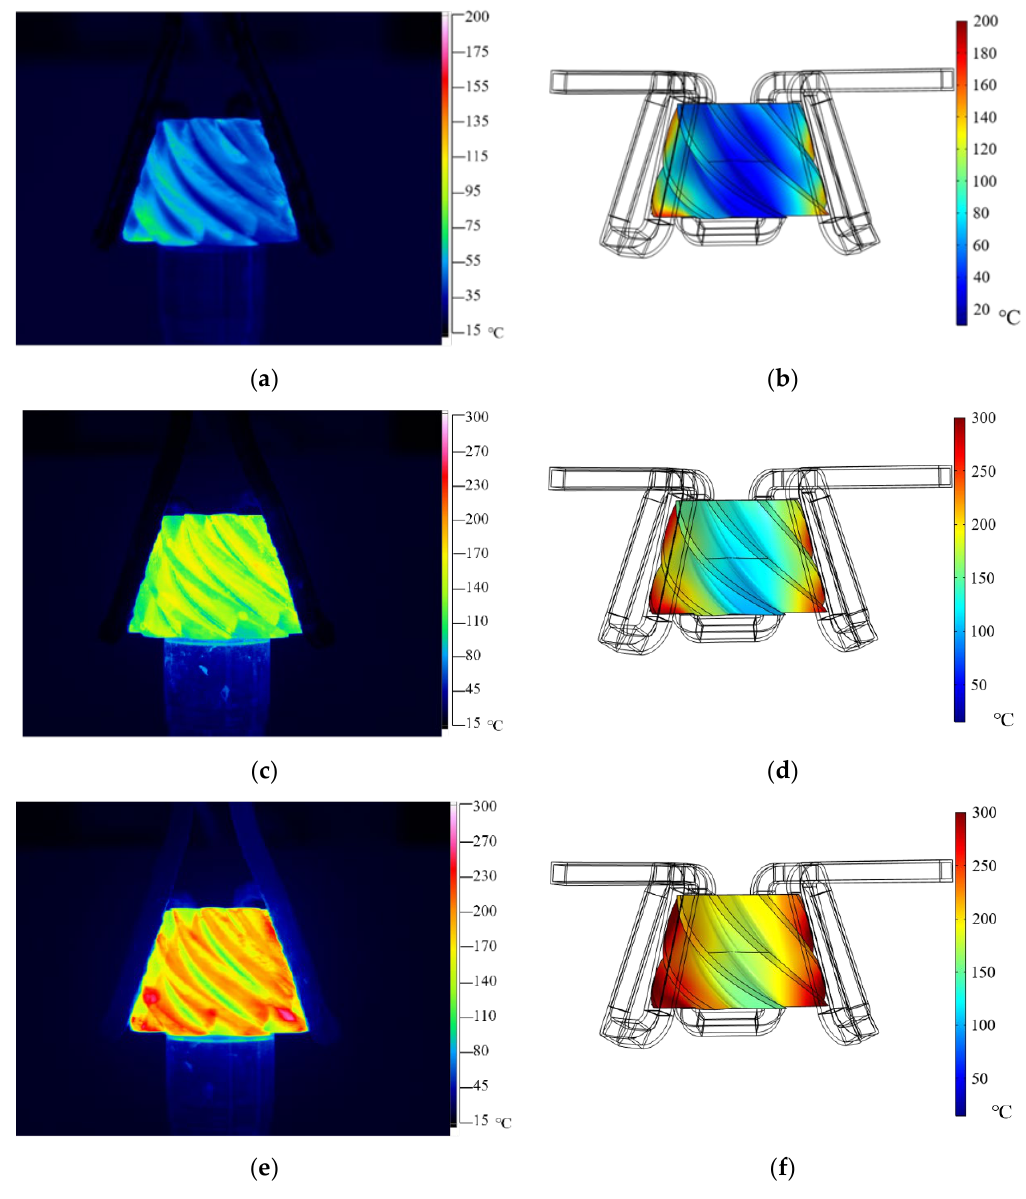
Figure 18. Gear tooth surface temperature distribution: ( a ) heating for 3 s in the experiment; ( b ) heating for 3 s in the simulation; ( c ) heating for 18 s in the experiment; ( d ) heating for 18 s in the simulation; ( e ) heating for 30 s in the experiment, and ( f ) heating for 30 s in the simulation.